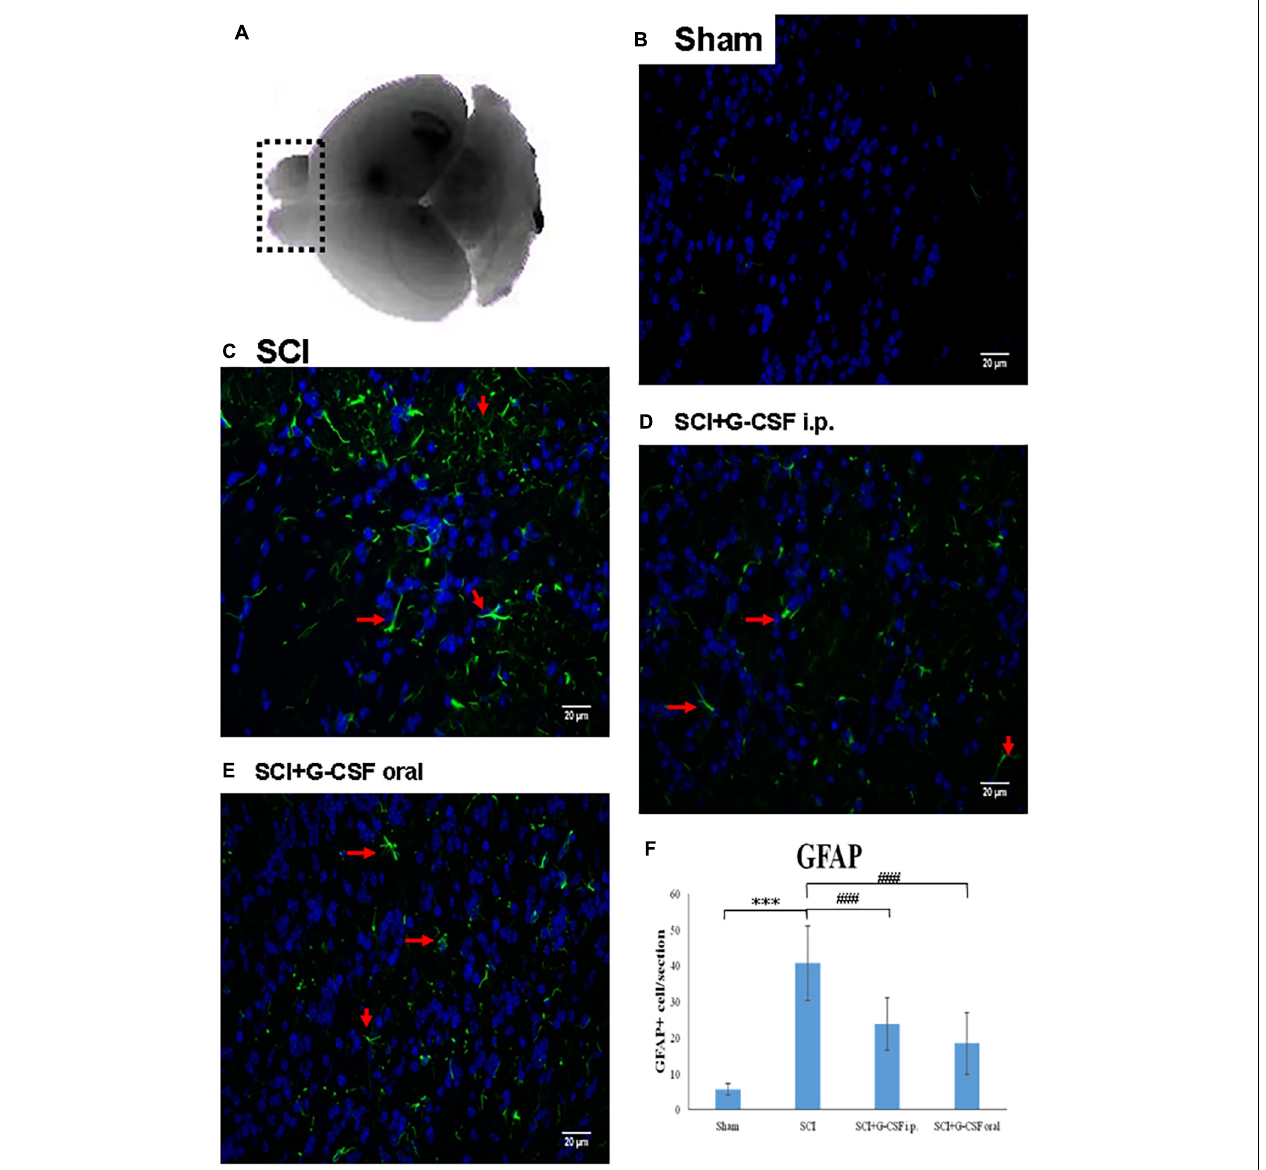
FIGURE 2 | Spinal cord injury (SCI) can activate the astrocytes in the olfactory bulb at 8 h post-spinal cord hemisection injury in mice. Representative images of GFAP-stained sections of the olfactory bulbs of the sham control (B) , SCI (C) , SCI + granulocyte colony-stimulating factor (G-CSF) i.p., and SCI + G-CSF oral groups. (A) Schematic illustration of the olfactory bulb (marked with dashed box) of all groups subjected to mRNA, protein, and immunofluorescence analyses. The SCI group exhibited a higher number of GFAP-positive cells [as indicated by arrow in panel (C) ] than the sham control group (B) . This indicated astrocytic activation and potential astrocyte-mediated inflammatory responses in the olfactory bulb at 8 h post-SCI. The immunofluorescence intensity of GFAP significantly decreased in the SCI + G-CSF i.p. [as indicated by arrow in panel (D) ] and SCI + G-CSF oral groups [as indicated by arrow in panel (E) ] [ (B–C) magnification 400 × ]. (E) Vertical bars indicate the mean ± standard error of mean) number of GFAP-stained cells in each group ( n = 3). *** P < 0.001 and ### P < 0.001.